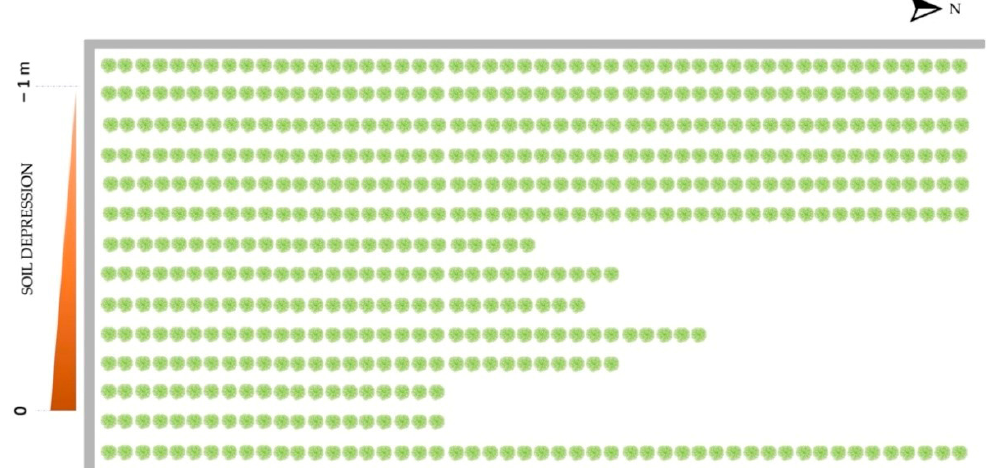
Figure 1. Schematic representation of the vineyard investigated (view from above). In green, the rows of grapevines; in gray, the concrete walls delimiting the field.